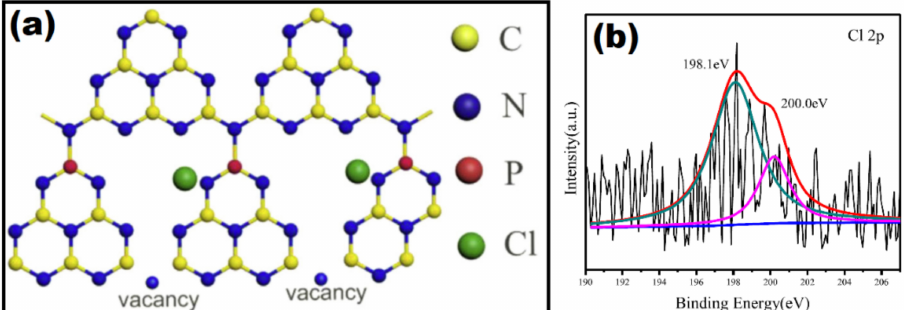
Figure 16. ( a )The schematic diagram of P, Cl-GCN and ( b ) XPS spectra for Cl 2p. Reproduced with permission from Ref.